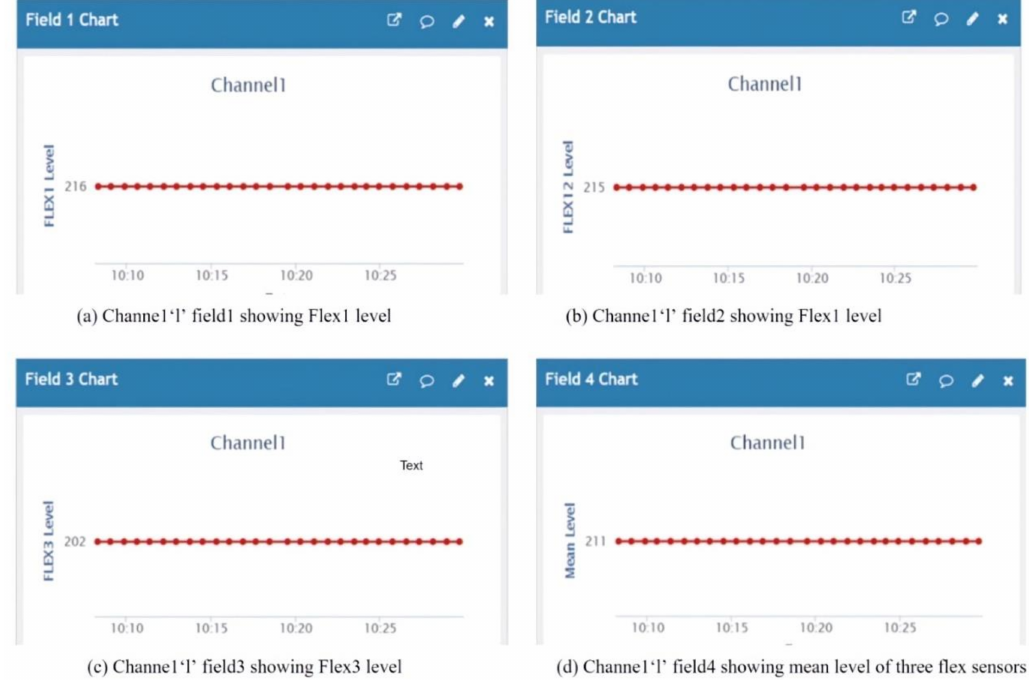
Figure 18. Channel ‘1’ showing the value of all three flex sensors with the mean